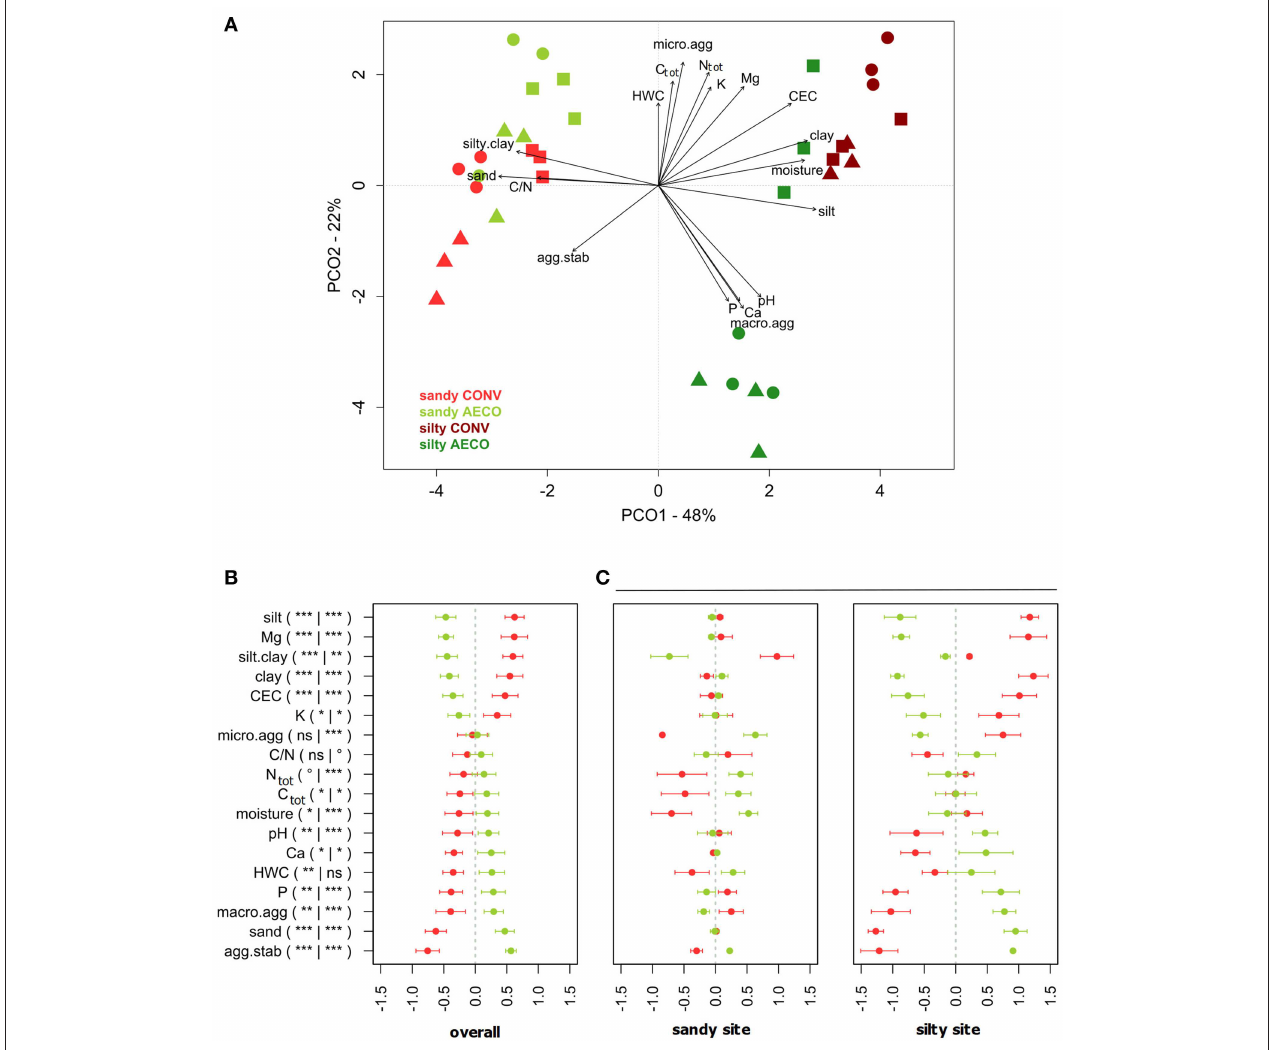
FIGURE 1 | (A) Principal coordinate analysis (PCO) based on Euclidean distances calculated from z -transformed values of physical and chemical soil parameters. The variance explained by the axes (goodness of fit) is provided next to the axis headers. Agricultural management types are colored coded with red (conventional, CONV) and green (agroecological, AECO). Light colors represent the sandy site; dark colors represent the silty site. The symbols represent the pairs: squares, samples belonging to pair n ◦ 1; circles, pair n ◦ 2; triangles, pair n ◦ 3 (see Supplementary Figure 1 ). (B) Standardized relative change in physical and chemical soil properties calculated from z -transformed values between conventional (red) and agroecological (green) management across all textural sites. (C) Standardized relative change in physical and chemical soil properties calculated from z -transformed values between conventional (red) and agroecological (green) farming systems separately for each textural site. P, K, Mg, and Ca, exchangeable cations; agg.stab, aggregate stability; C tot , carbon total; clay, % of clay particles; silt, % of silt particles; sand, % of sand particles; micro, % of micro-aggregates; macro, % of macro-aggregates; silt.clay, % of silt and clay fraction; C/N, carbon to nitrogen ratio; HWC, hot water carbon; N tot , total nitrogen; CEC, cation exchange